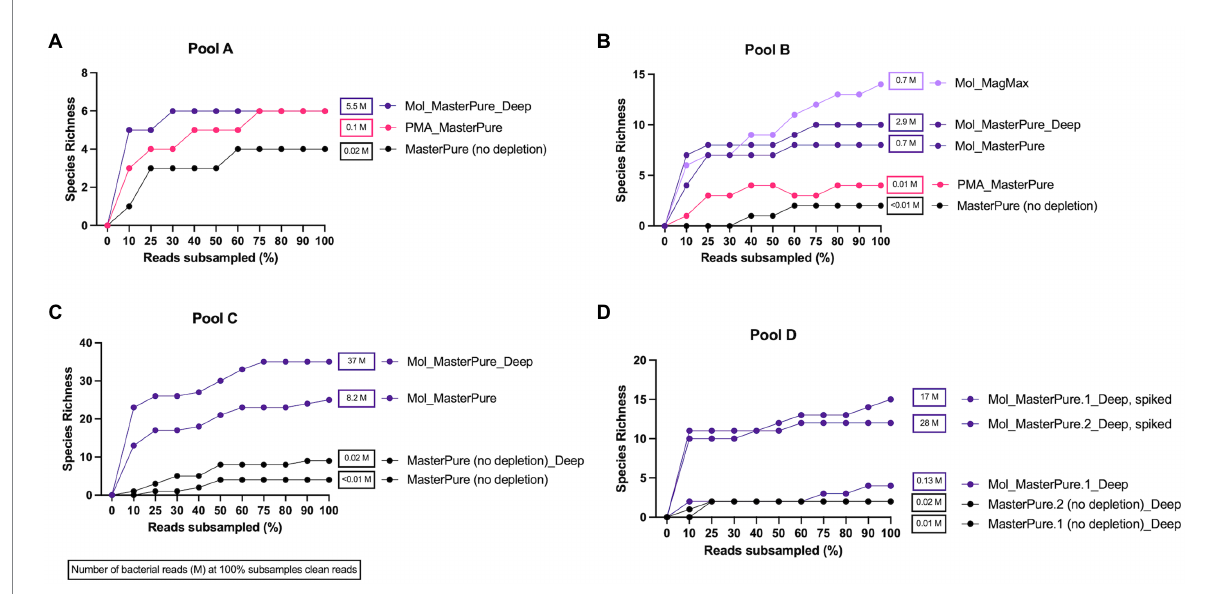
FIGURE 4 Rarefaction analysis. Rarefaction analysis. Rarefaction curves at species level for samples at various sequencing depth (% clean reads) for pools A (A) , B (B) , C (C) , and D (D) . Protocols including MolYsis for host DNA depletion retrieved highest species richness across all pools. Number of bacterial reads obtained at 100% clean reads are listed next to samples rarefaction curve.